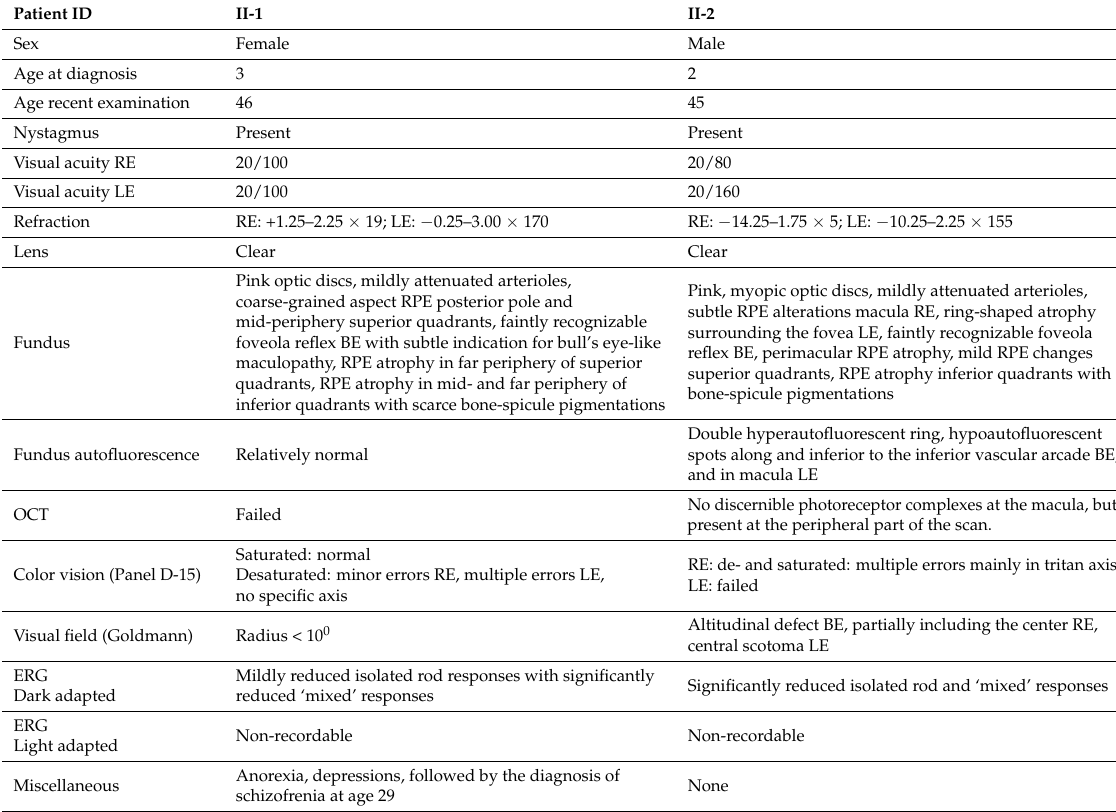
Table 1. Clinical characteristics of two patients with variants in CEP290